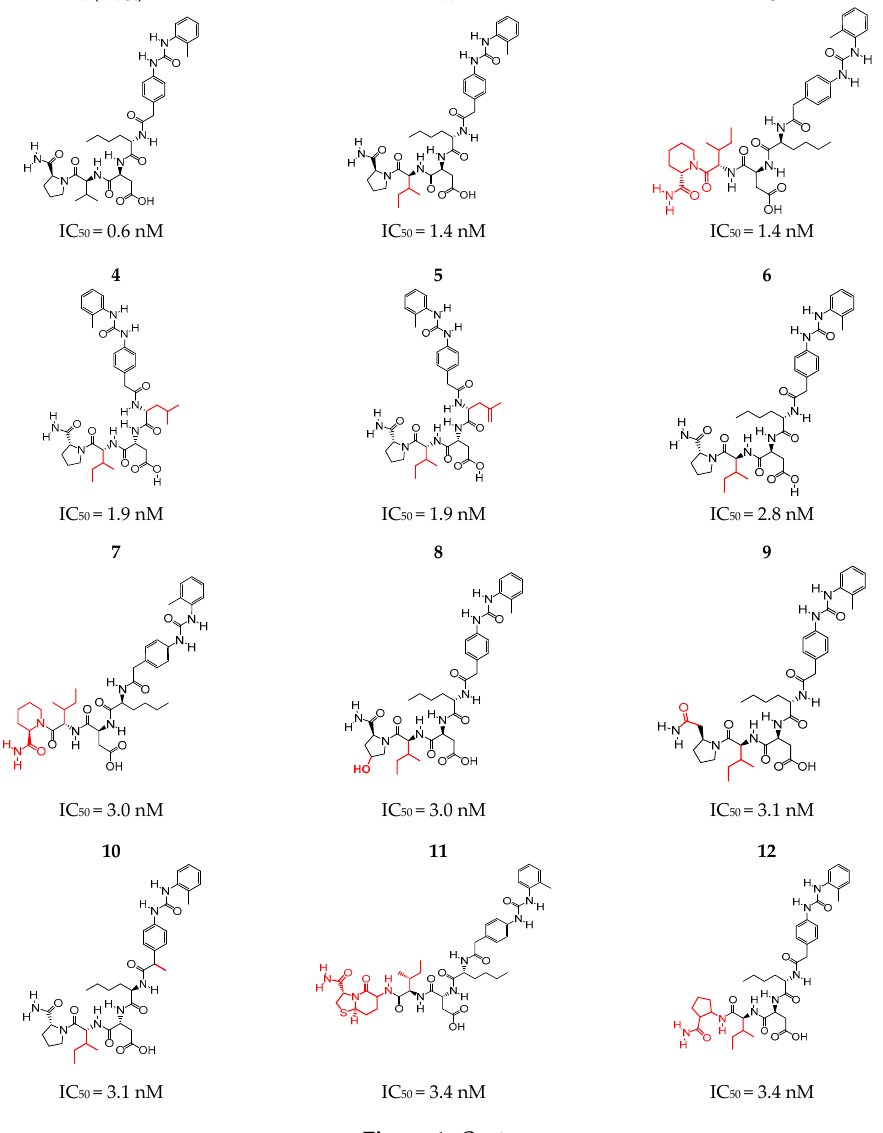
Figure 1. Cont. Figure 1.